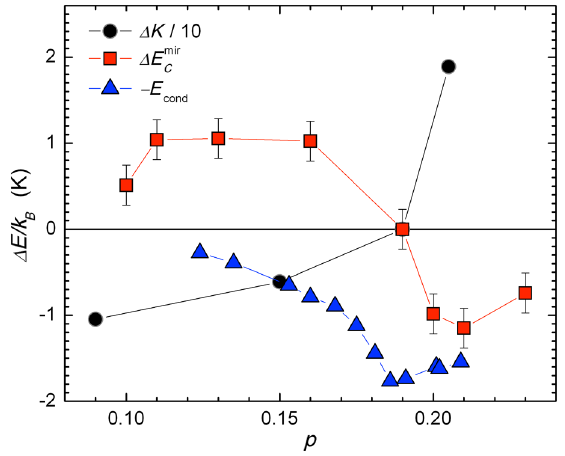
FIG. 5. The S – N difference of the q -integrated Coulomb energy Δ E mir , together with the total energy difference − E C reproduced from Ref. [44], with original units converted to the present ones for the sake of comparison) and band-energy difference Δ K